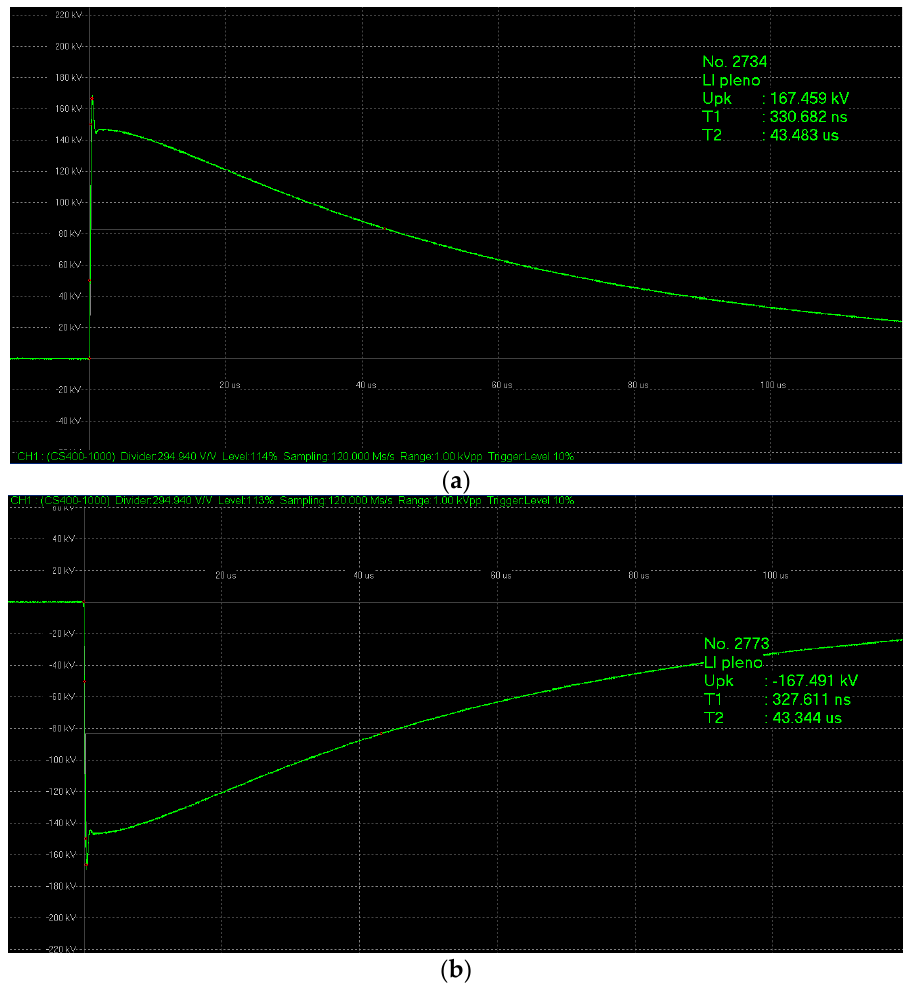
Figure 5. No-load impulses: ( a ) positive polarity; ( b ) negative polarity.